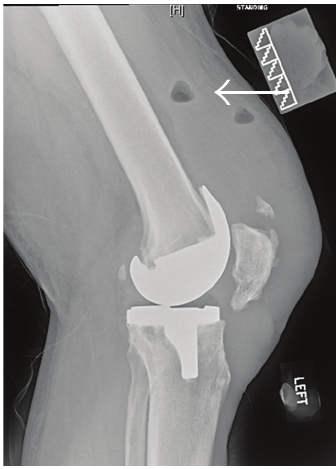
Figure 1: Lateral left knee X-ray showing a patella baja, fluid collection near the quadriceps tendon, and the presence of gas in the thigh, with query infection.